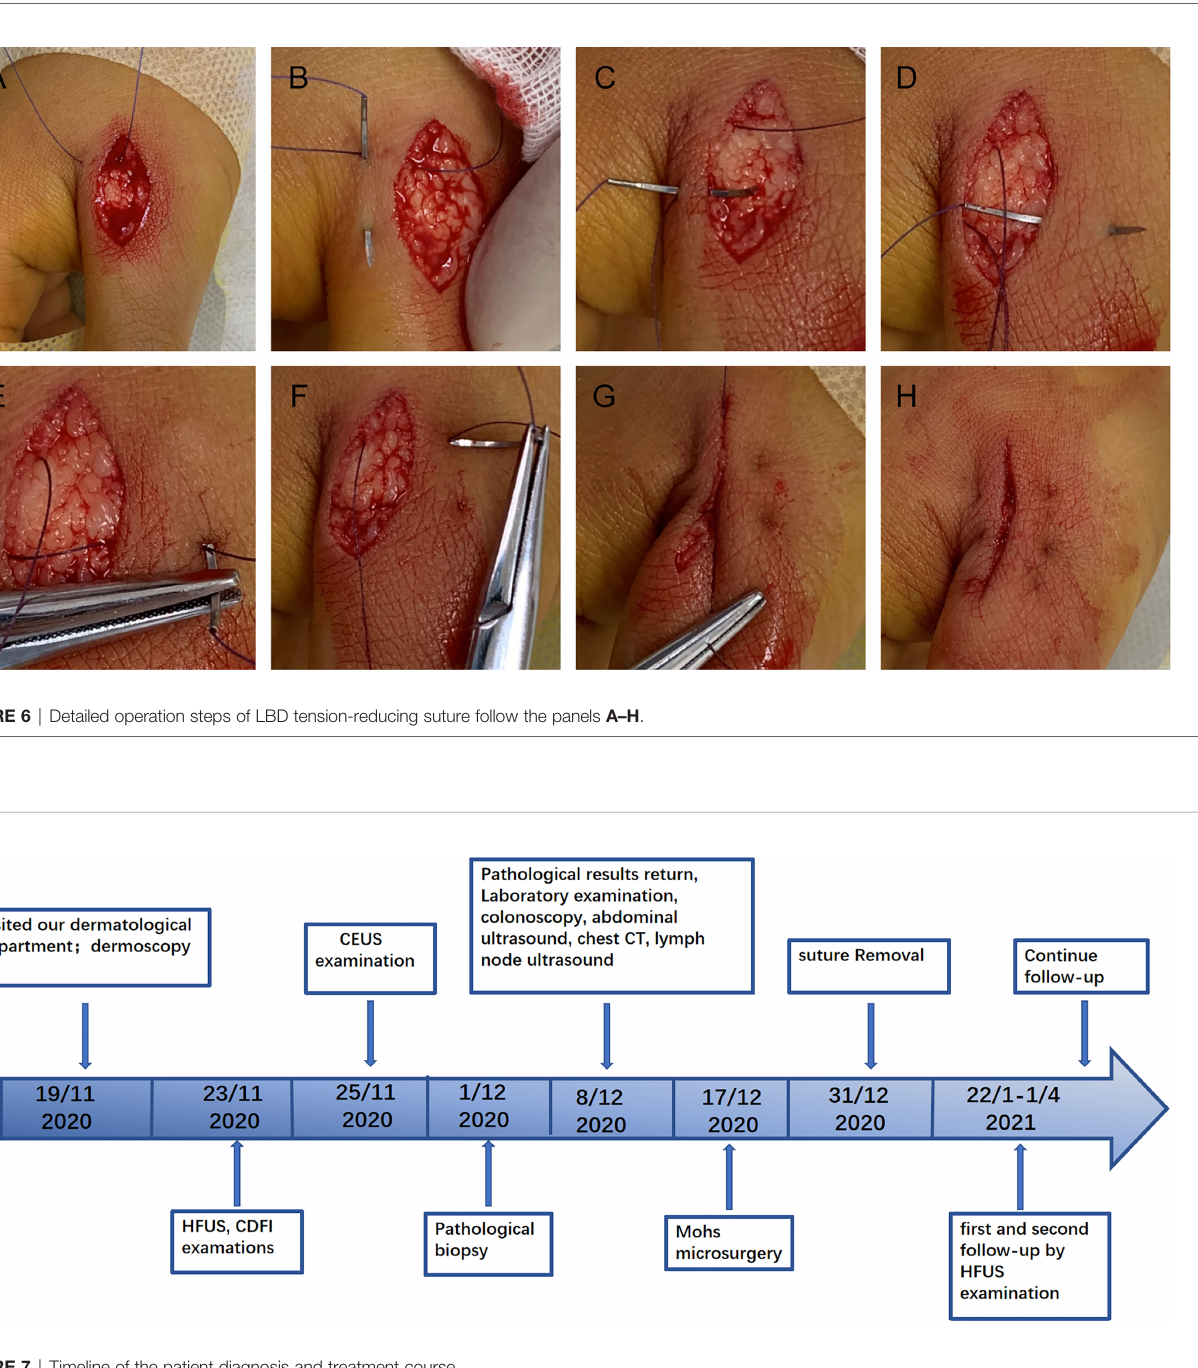
FIGURE 7 | Timeline of the patient diagnosis and treatment